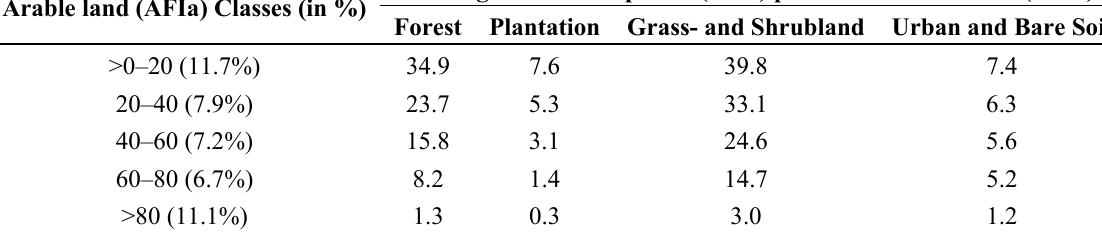
Table 1. Average land occupation (in percent) within five arable land (AFIa) classes (fractional coverages of 0–20%, 20%–40%, 80%–100%) of Tuscany. The values indicate the number of pixels in relation to the total number of pixels within the AFIa class (in percent). The relative number of AVHRR pixels for each of the five arable land AFIa classes is indicated in the first column (in parentheses) in relation to the total pixel number of the study region. The information is derived from official AGRIT statistics [30] and CORINE data.